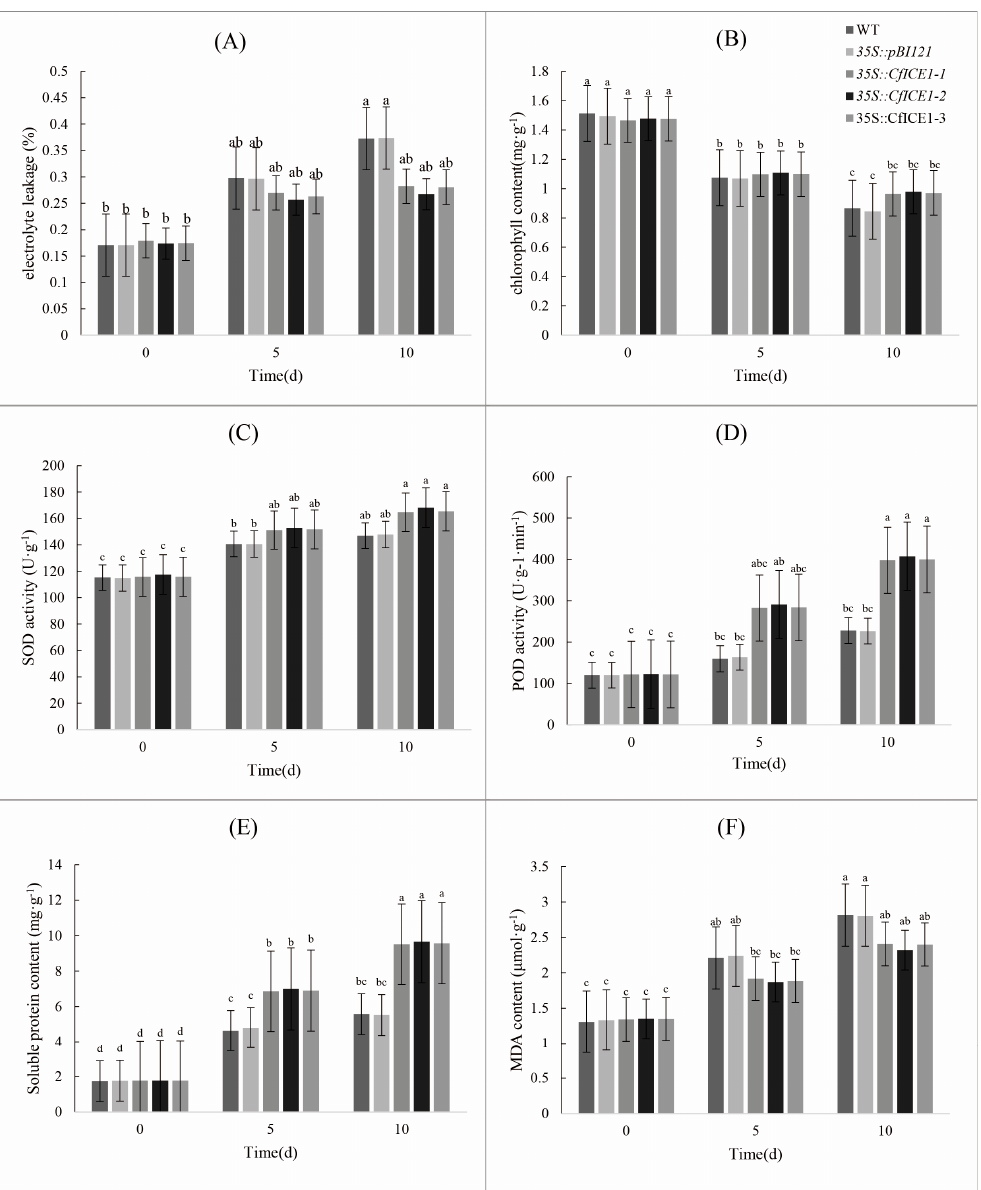
Figure 7. Physiological indices of transgenic, empty vector and wild ‐ type poplar lines under drought stress: ( A ) Electrolyte leakage, ( B ) Chlorophyll content, ( C ) SOD activity, ( D ) POD activity, ( E ) Soluble protein content, ( F ) MDA content. The abscissas of all the above physiological indicators are the days of drought treatment. Each bar indicates the average ± SD (n = 3), and lowercase letters above each bar indicate significant differences ( p ≤ 0.05).